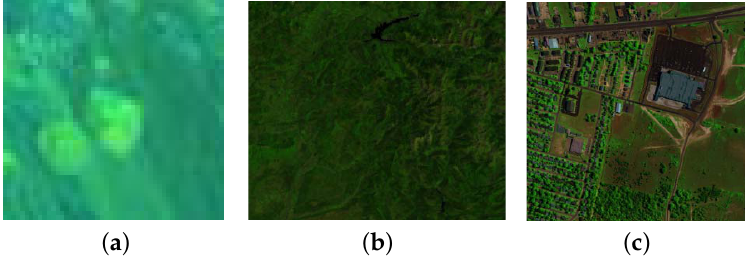
Figure 3. False-color image of ( a ) Cuprite, ( b ) gulf of Lion and ( c )